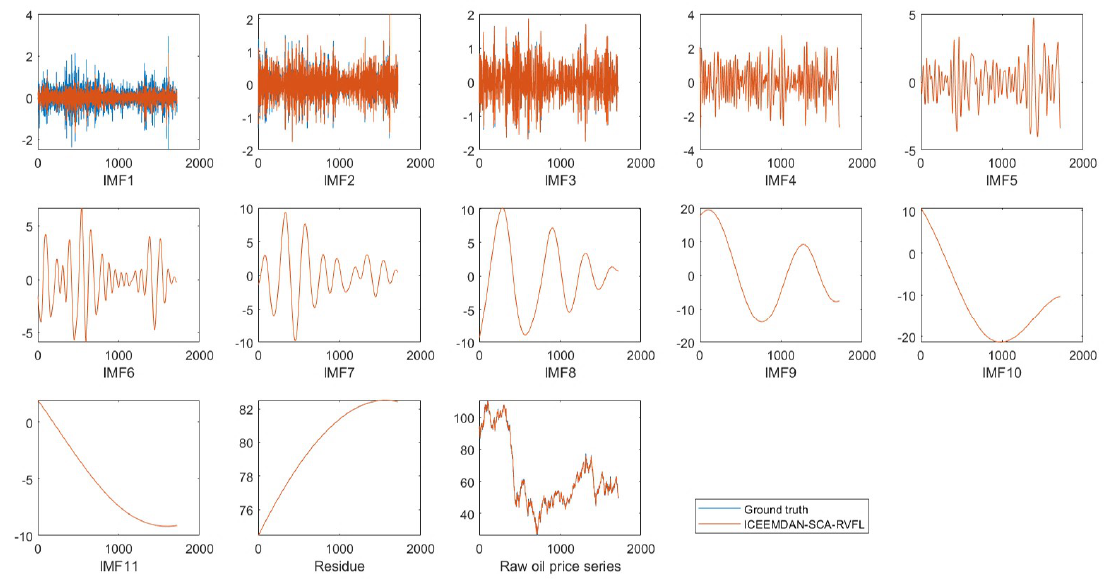
Figure 5. Individual prediction result of each component and ensemble prediction result by